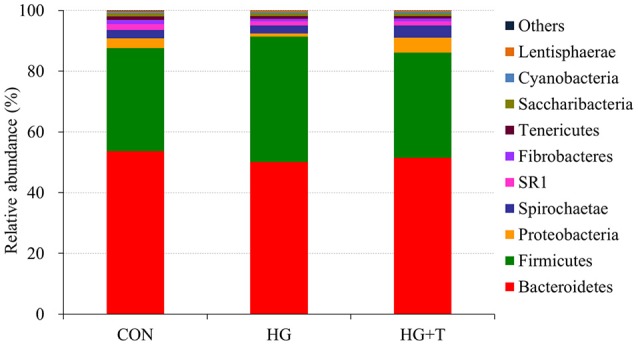
Percentage composition of the top 10 predominant phyla in rumen fluid.